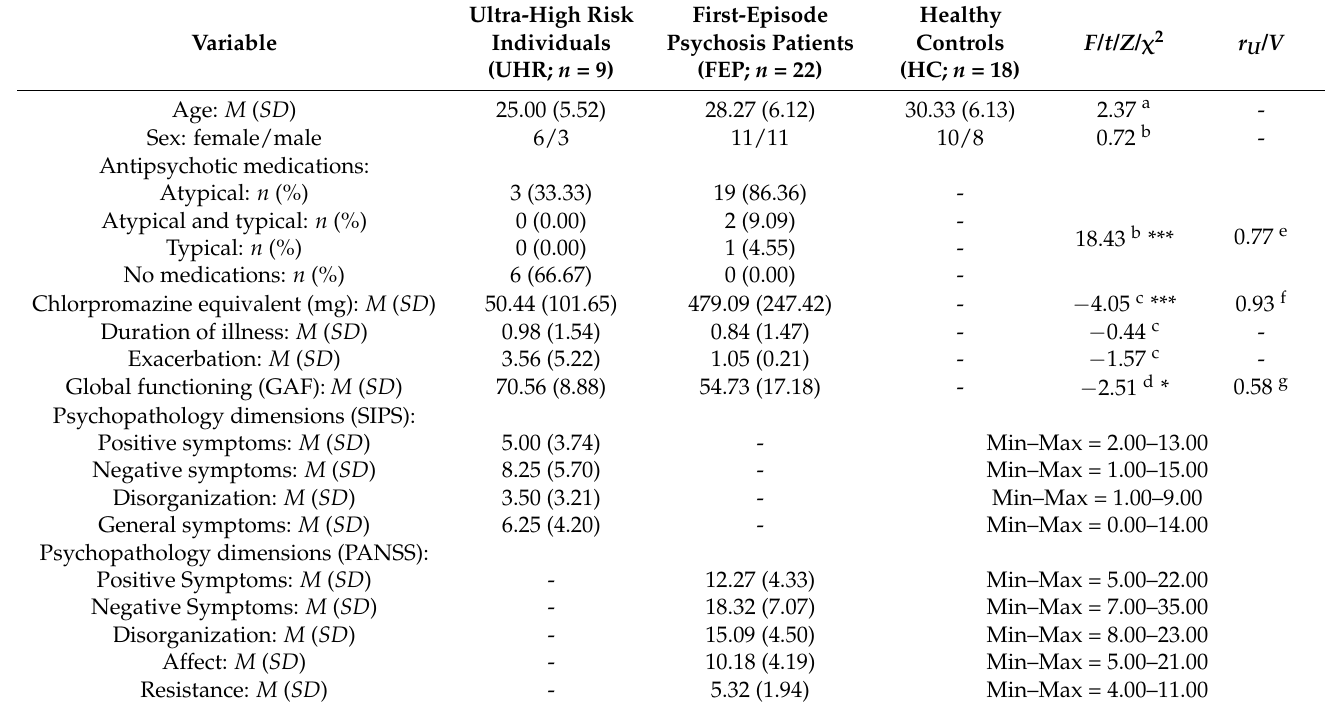
Table 1. Demographic and clinical characteristics of participants from the three groups.